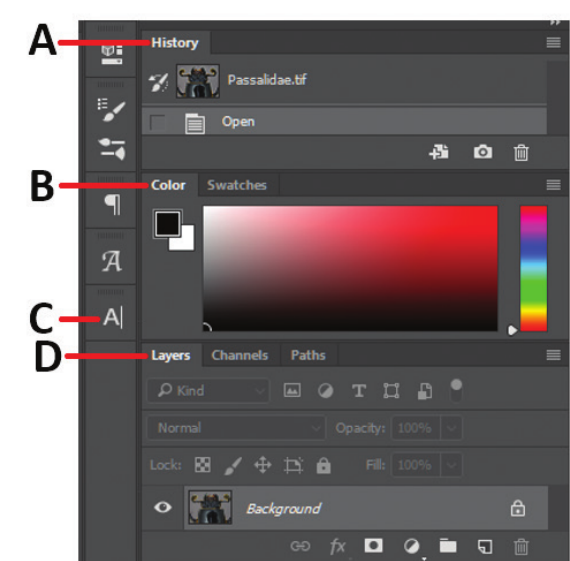
Figure 5. Docked adjustment Panels. A . History panel; B . Co- lour panel; C . Character panel; D . Layers